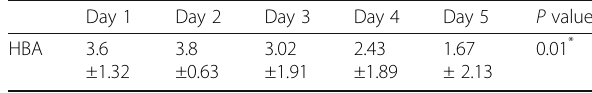
Table 4 Mean levels of HBA through different days of menses